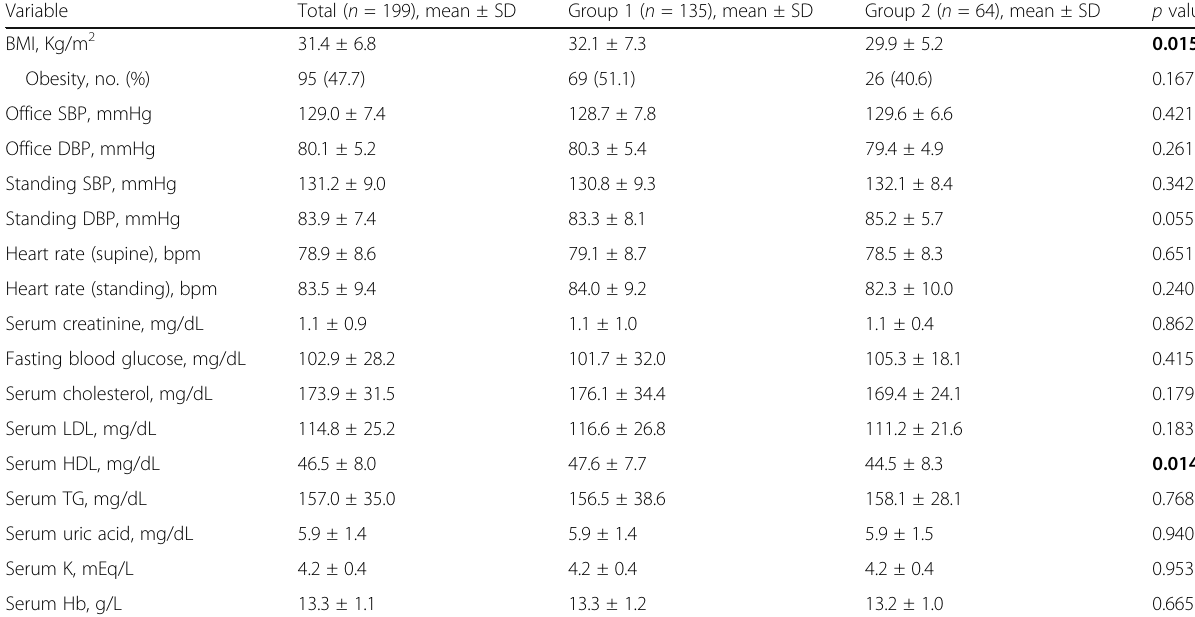
Table 2 Examination and laboratory findings Variable